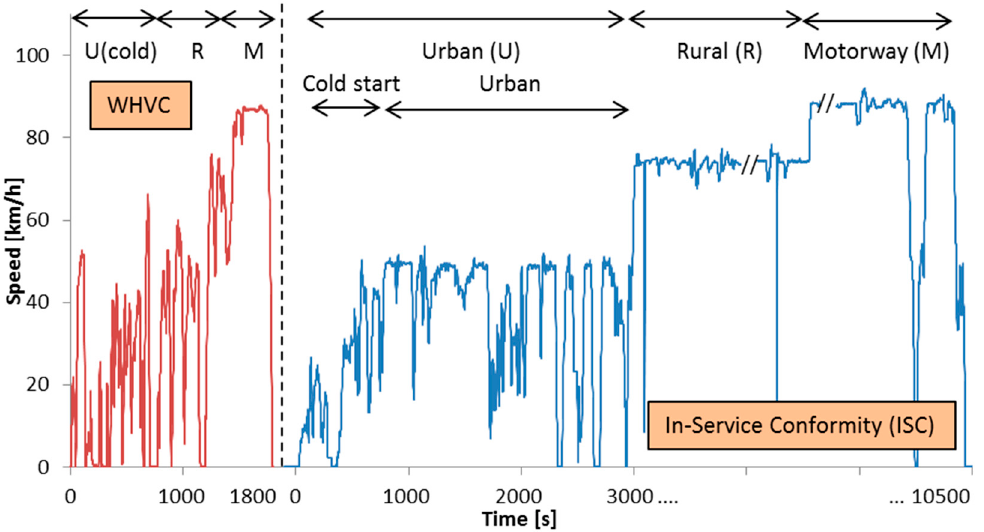
Figure 1. Test cycles: WHVC (World Harmonized Vehicle Cycle) and an example of an ISC (In-Service Conformity) cycle (plotted in the same figure for illustrative purposes). Note that parts of the rural and motorway phases have been cut for better visualization.